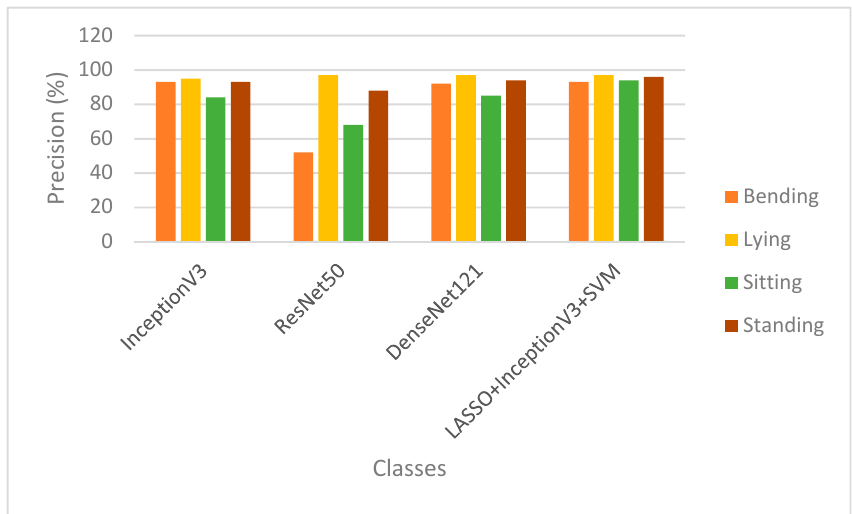
Figure 5. Results of the classification of a particular class classification result .